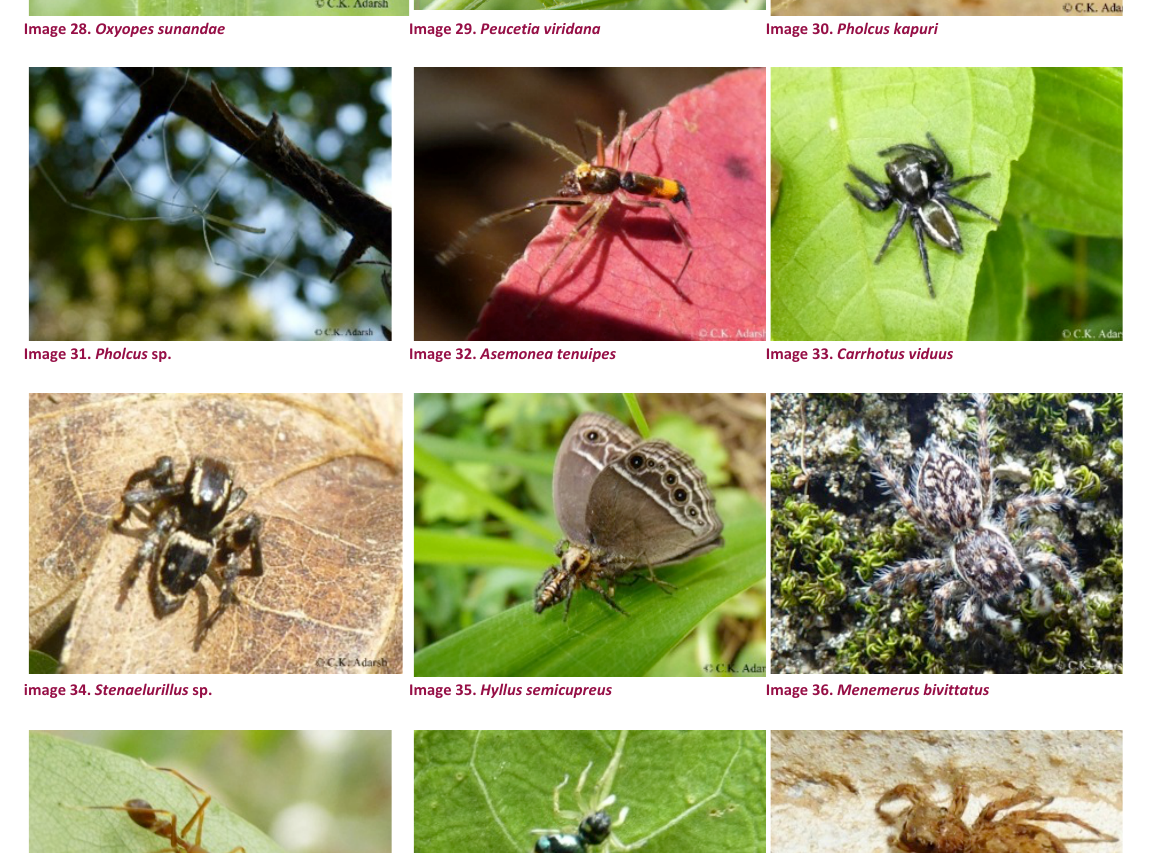
Image 28. Oxyopes sunandae Image 29. Peucetia viridana Image 30. Pholcus kapuri